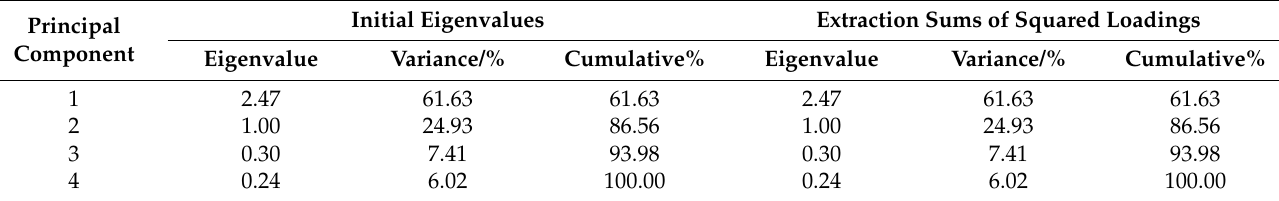
Table 2. Eigenvalues and variance contributions of the four principal components.